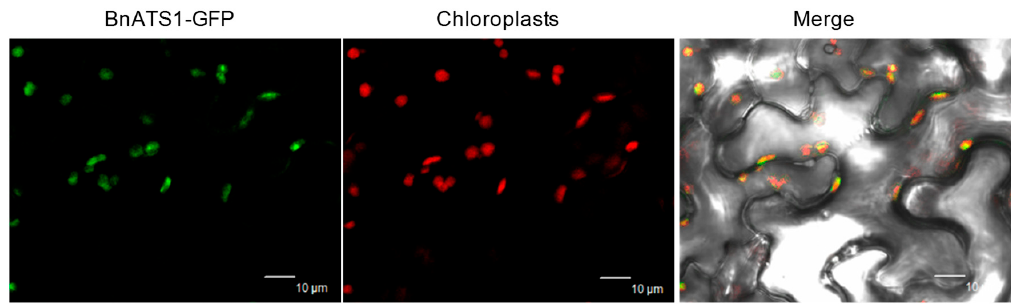
Figure 1. BnATS1 expression pattern and BnATS1 activity. ( A ) The expression pattern of BnATS1 in Brassica napus detected by RT-qPCR normalized to BnActin . Total RNA was extracted from various tissues of cv. Westar. Values are means ± SD ( n = 3 separate samples). Leaves, roots, meristem, and stems were sampled from 40-day-old plants; flowers and flower buds were sampled from plants at the flowering stage; siliques, 10 days after pollination; developing seeds, 20 days after pollination; developing silique walls, 20 days after pollination; mature seeds, 45 days after pollination. ( B ) BnATS1 catalyzes the acylation of glycerol-3-phosphate using C16:0-CoA as an acyl donor to generate lysophosphatidic acid (LPA) in vitro. Values are means ± SD ( n = 3 independent experiments). LPA, lysophosphatidic acid.